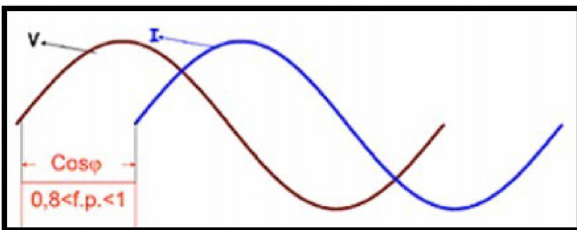
Figure 3. Phase difference between the voltage and current